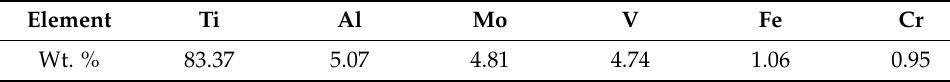
Table 1. The chemical composition of Ti-55511 alloy (all in wt %).